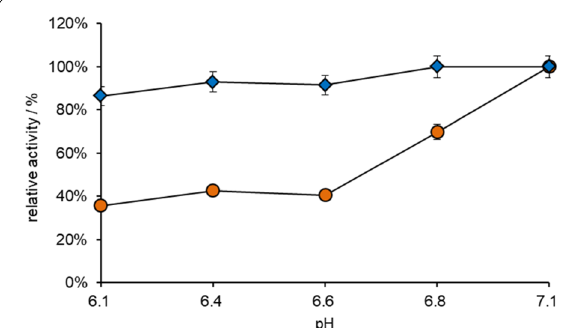
Fig. 2 The activity of GldA (orange circle) and SpNox K184R (blue square) at different pH, ranging from 6.1 to 7.1 (100 mM K 2 HPO 4 and KH 2 PO 4